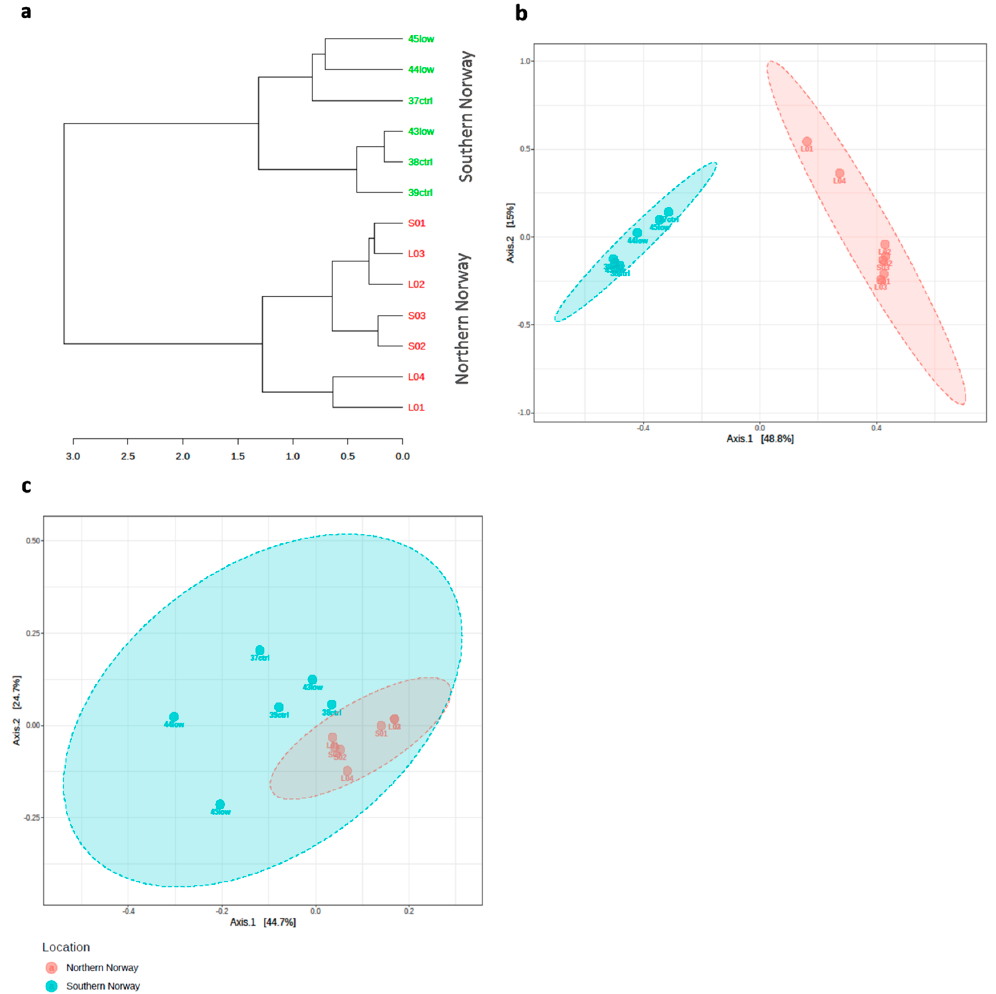
Figure 2. Microbial community composition in Atlantic cod gut samples from northern and southern Norway. ( a ) Hierarchical clustering of amplicon sequence variant (ASVs) abundances generated through Bray–Curtis distance metric and Ward’s linkage method. ( b ) Principal coordinate analysis (PCoA) ordination of all the samples based on the beta diversity analysis of ASV abundances generated using the Bray–Curtis distance metric. ( c ) Nonmetric multidimensional scaling (NMDS) beta diversity ordination of individual samples calculated with weighted UniFrac distances. Oil exposure treatment codes: ctrl = control (no oil), low = low concentration of oil [11]; L = Lofoten; S = Sørøya.